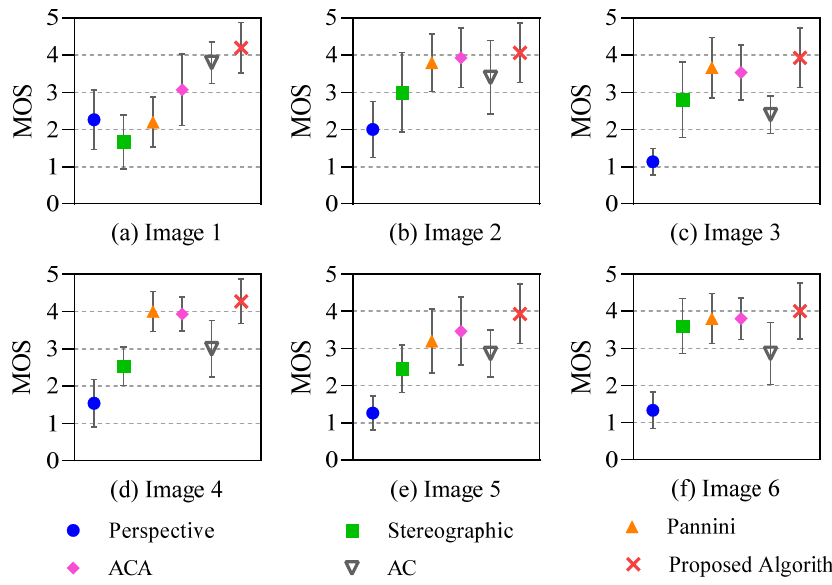
Figure 19. Mean opinion score (MOS) values of the viewport images shown in Figure 18.